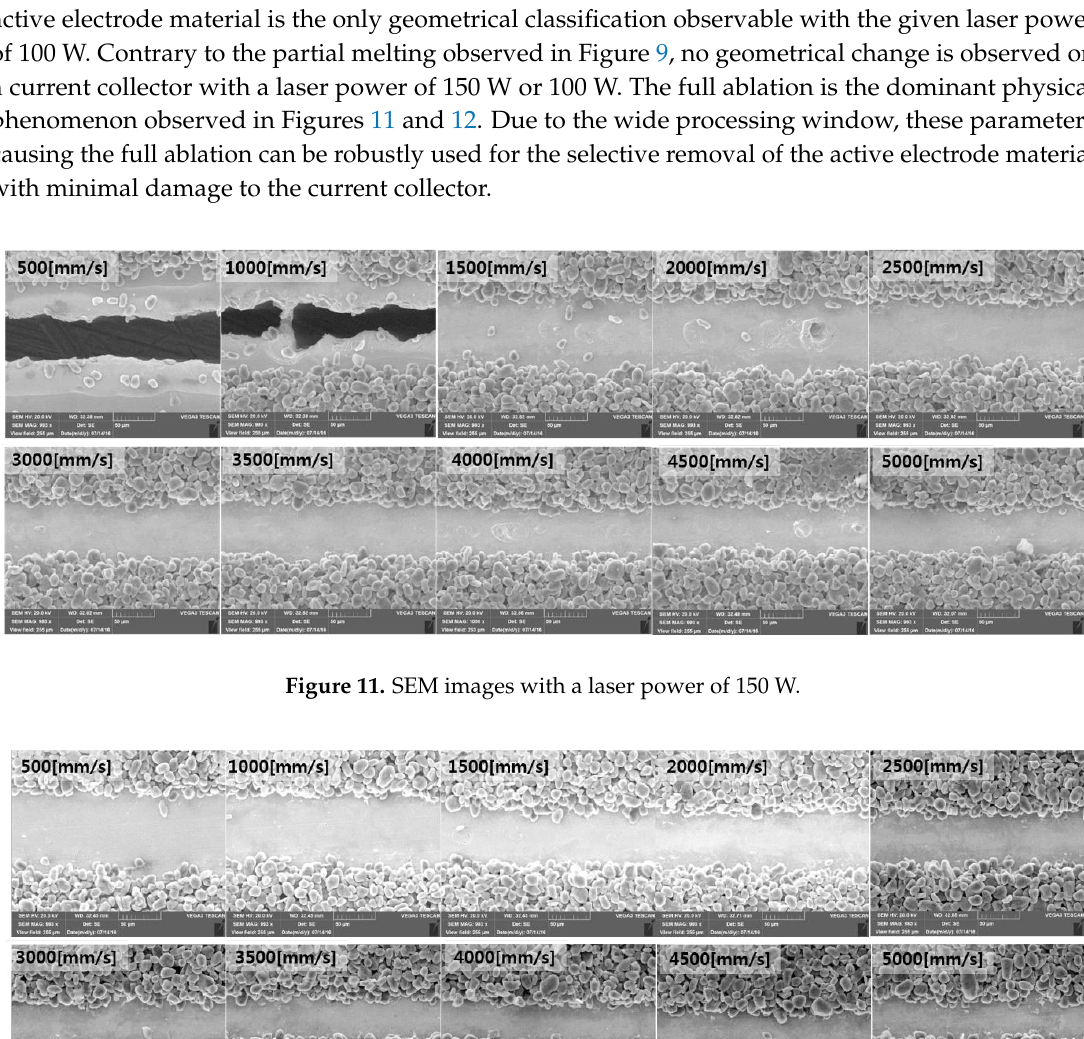
Figure 11. SEM images with a laser power of 100 W.